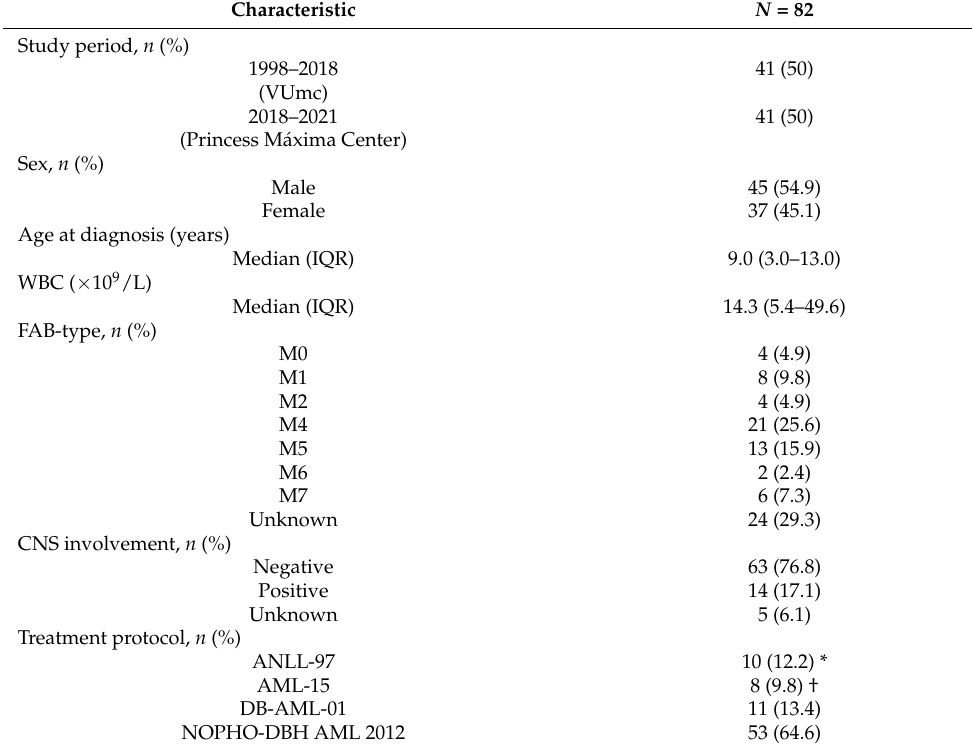
Table 1. Clinical characteristics of pediatric acute myeloid leukemia